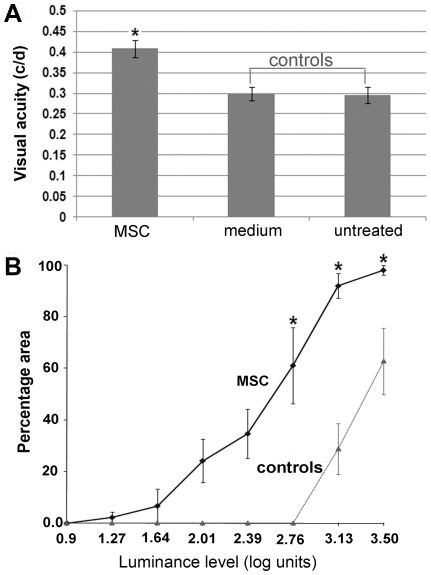
Preservation of visual function.A. Visual acuity tested by Optomotor response. Unrestrained animals were placed on a platform, where they tracked the grating with reflexive head movements. The acuity threshold was quantified by increasing the spatial frequency of the grating. RCS rats received MSCs and medium injection via tail vein at P30 and tested at P90. Visual acuity was significantly better in MSC treated eyes compared with controls (P<0.001). A value of 0.43 c/d was recorded, which was 78% of normal value (0.55 c/d in wild-type). B. The luminance threshold was evaluated by recording single and multiunit activity close to the surface of the superior colliculus (SC). It measures functional sensitivity across the visual field, which in turn provides a topographic indication of the magnitude and area of photoreceptor rescue across the retina. MSC treated rats recorded around P90–100 revealed significantly lower threshold than controls (P<0.005), for example, over 60% of the SC area had threshold at 2.76 log units in MSC treated eyes, no detectable response in control eyes.